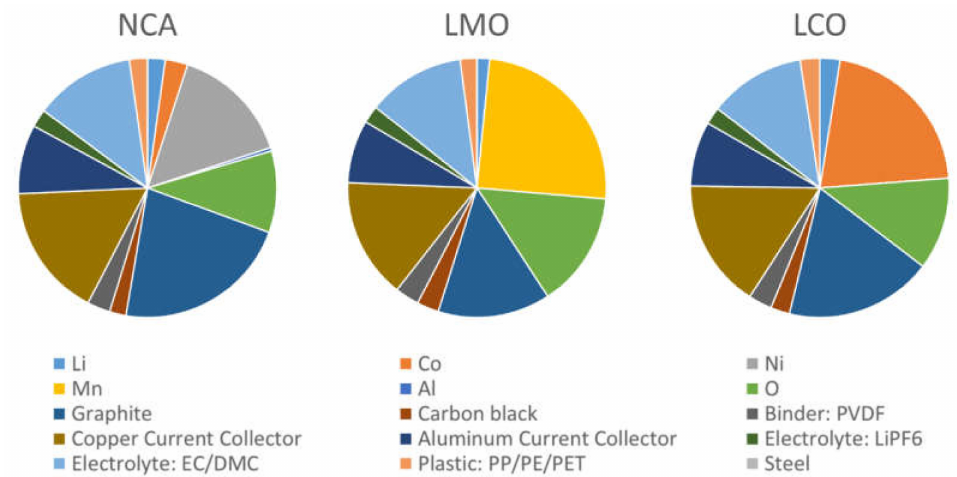
Figure 1. Percentage breakdown of components of a typical lithium ion battery (LIB) cell with di ff erent cathode materials LiNi 0.8 Co 0.15 Al 0.05 O 2 (NCA), LiMn 2 O 4 (LMO) and LiCoO 2 (LCO); identifying